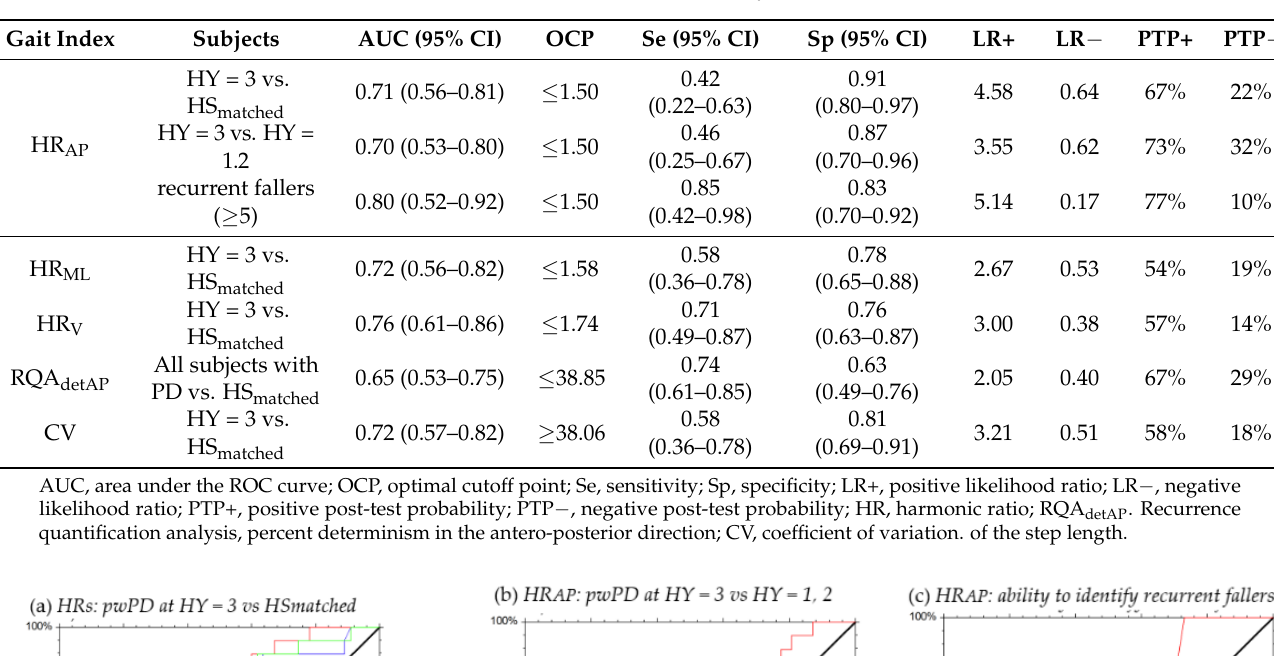
Table 2. ROC curve and cutoff analysis results.